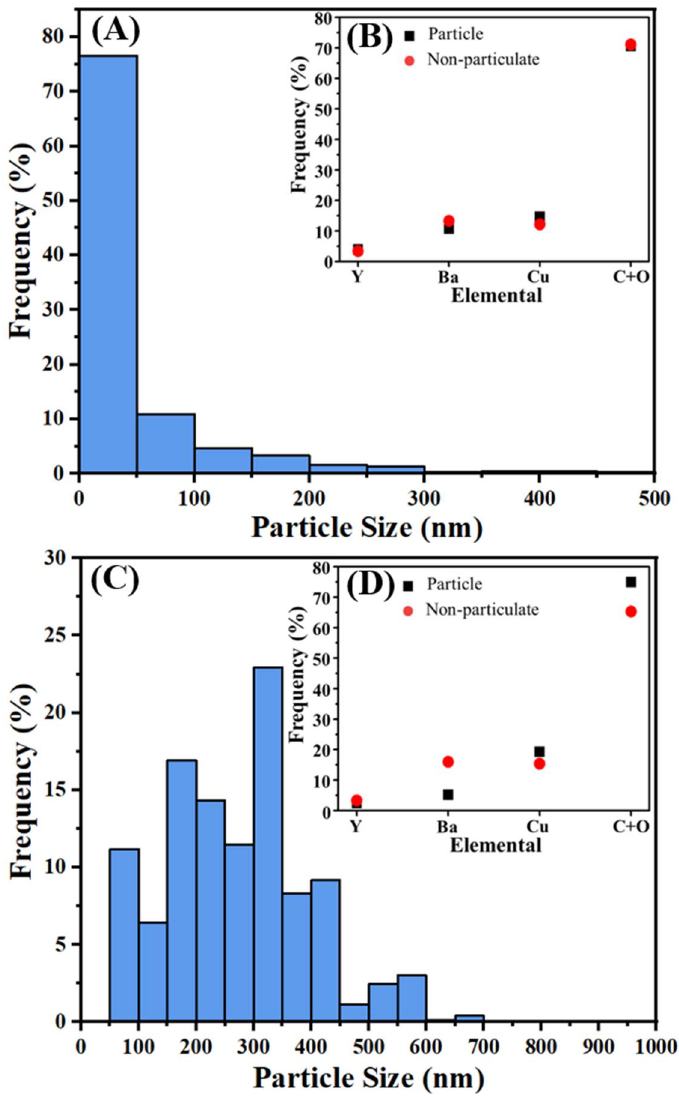
Figure 5. Statistical histograms of surface particle size for low vacuum pyrolysis film and conventional pyrolysis film, and elemental proportions for EDS measurements. ( A ) Statistical histograms of surface particle size for low vacuum pyrolysis film (15 ◦ C/min), ( B ) elemental proportions of surface granular and non-granular regions. ( C ) Statistical histograms of surface particle size for conventional pyrolysis film (0.5 ◦ C/min), ( D ) elemental proportions of surface granular and non-granular regions.